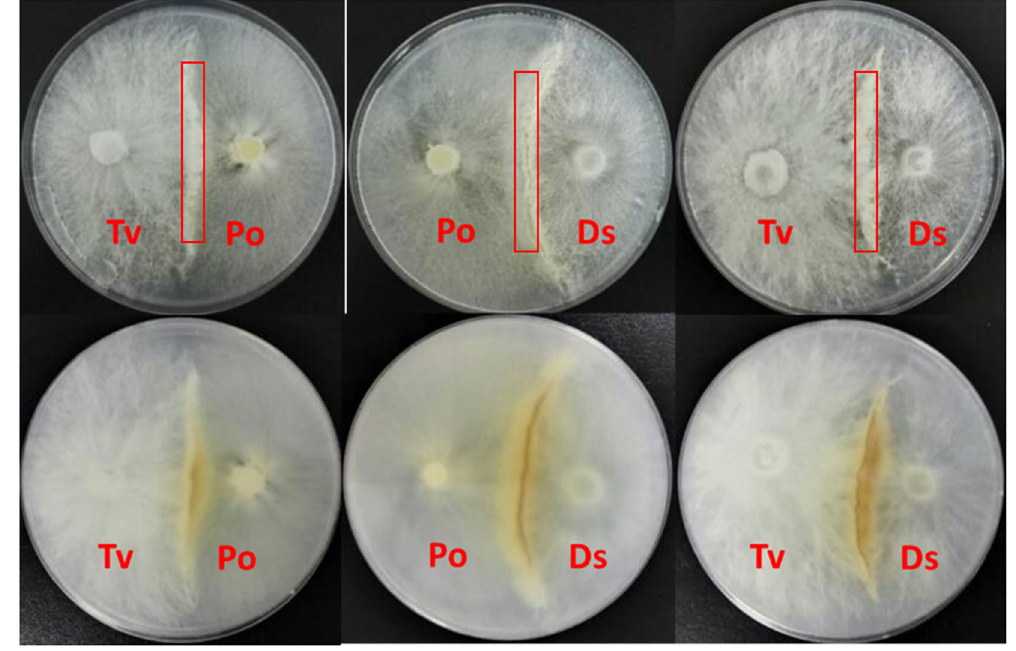
Figure 1. Paired-culture on Sc agar plate among Tv, Ds and